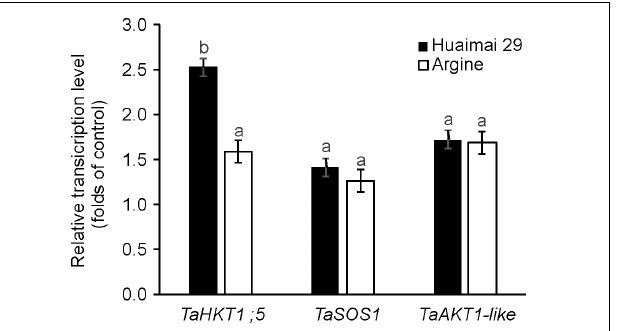
FIGURE 7 | The relative gene expression in shoots of salt-tolerant wheat (cv. Huaimai 29) and salt-sensitive wheat (cv. Argine) after exposure to salt stress (150 mM NaCl, 24 h). Mean ± SE ( n = 3 biological replicates). Different lowercase letters indicate a significant difference ( P < 0.05).